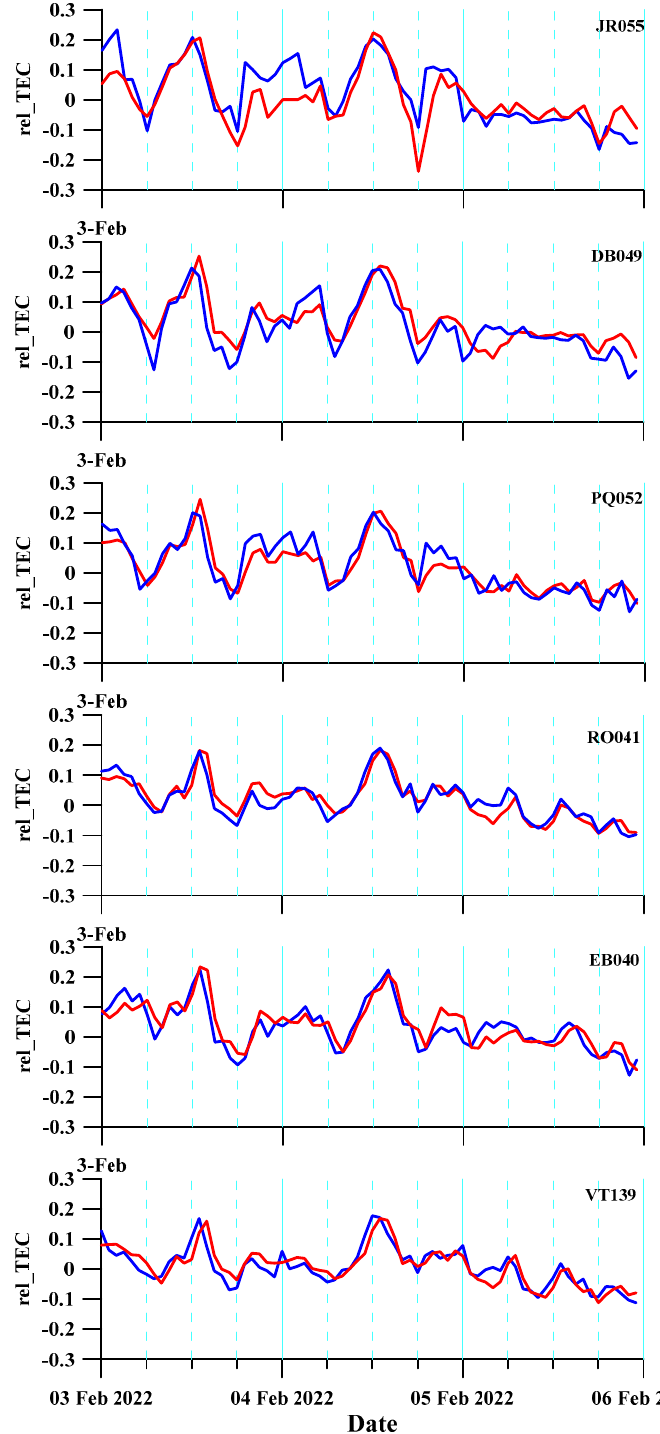
Figure 6. Comparison of relative TEC by CODE (marked with red) and Madrigal (marked with blue) at points with the coordinates closest to the ionosonde stations.